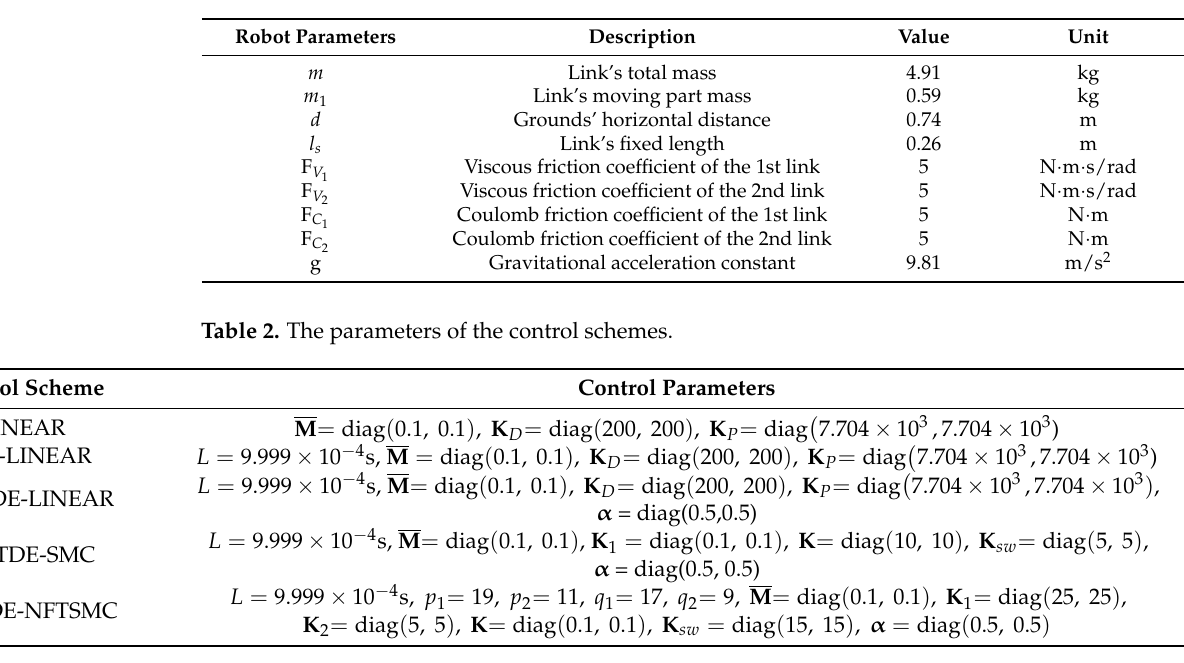
Table 1. The robot parameters.